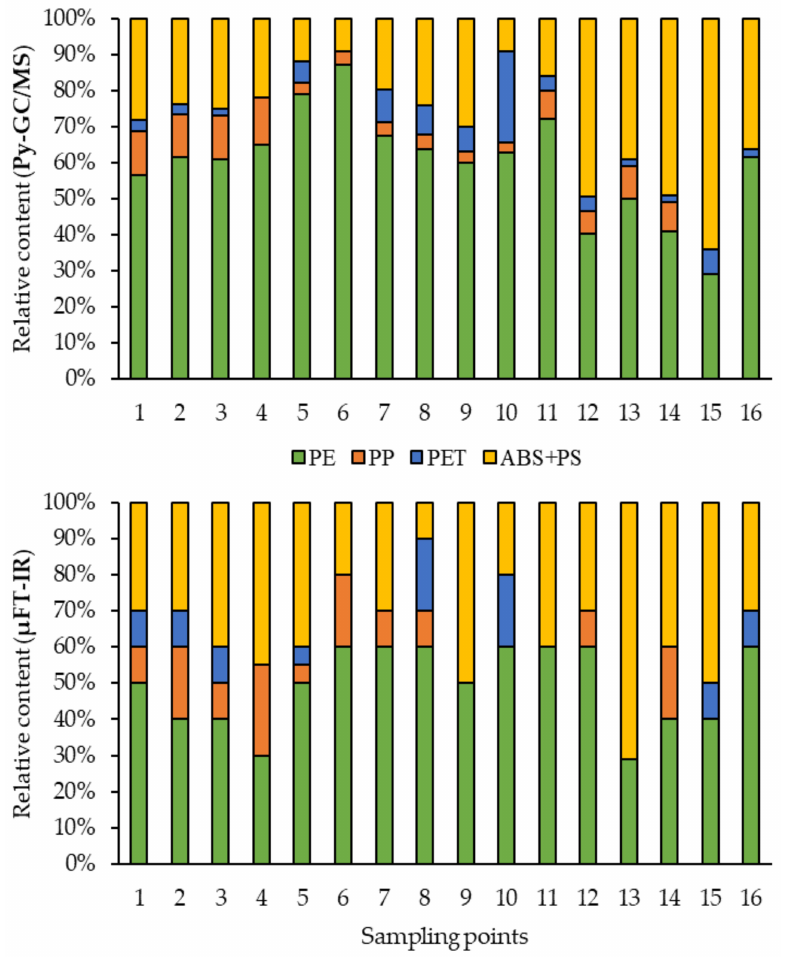
Figure 3. Relative content of detected